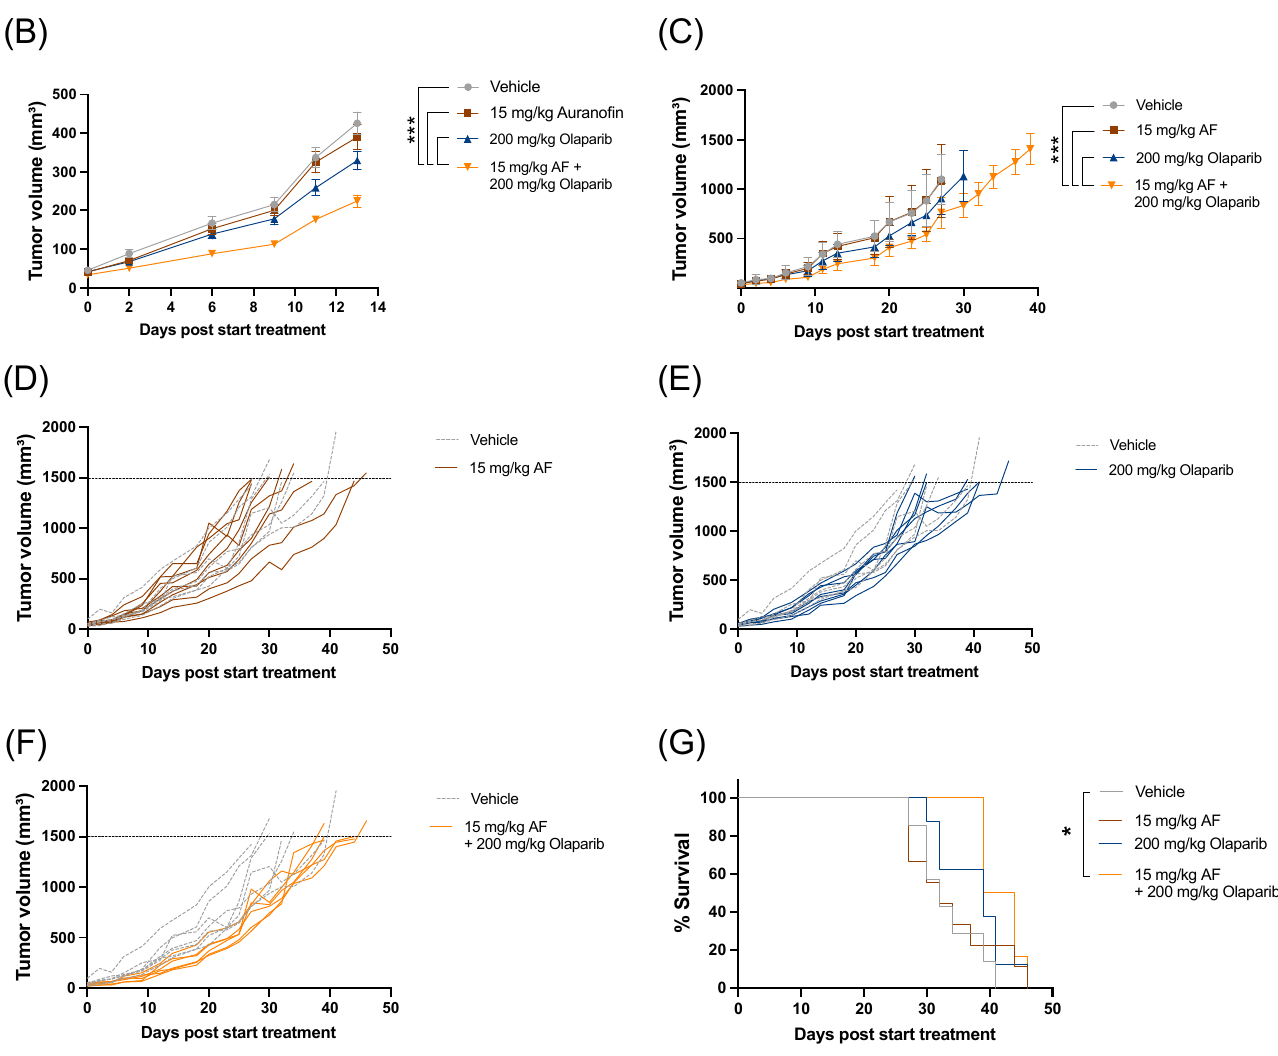
Figure 5. Tumor kinetics and survival after aurola combination therapy in syngeneic lung adenocarcinoma mouse model. Male 129S2/SvPasCrl (129-) mice were injected with 1 × 10 6 344SQ cells subcutaneously. When tumors reached a size of 40–50 mm 3 (day 0), mice were randomized and treated with vehicle, AF (15 mg/kg), olaparib (200 mg/kg), or aurola (15 mg/kg AF + 200 mg/kg olaparib). ( A ) Treatment scheme showing timing of AF treatment (15 mg/kg via oral gavage administered for 14 consecutive days) with black arrows and olaparib treatment (200 mg/kg via oral gavage administered for 14 consecutive days) with red arrows. ( B ) Tumor growth kinetics until day 13 after different treatments as indicated ( n = 12–14 mice per group). Error bars represent the standard error of the mean. ( C ) Tumor growth kinetics over time ( n = 6–8 mice per group) after different treatments as indicated. Error bars represent the standard deviation. ( D – F ) Spaghetti plots of tumor volumes for individual mice in each treatment group (solid lines) compared to individual mice in vehicle group (dotted lines). ( G ) Survival of 129-mice ( n = 6–8 mice per group) after different treatments as indicated. * p ≤ 0.05; *** p ≤